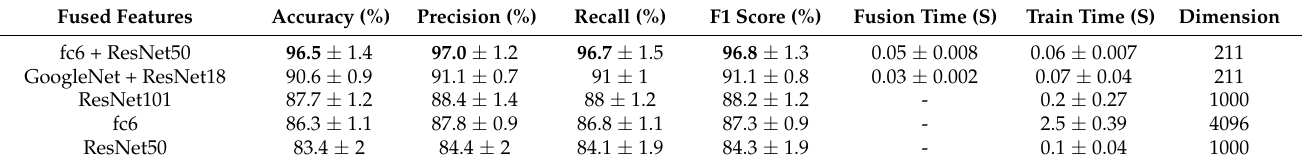
Table 4. Performance comparison between the fused deep features and a single feature. (Bold font shows the best